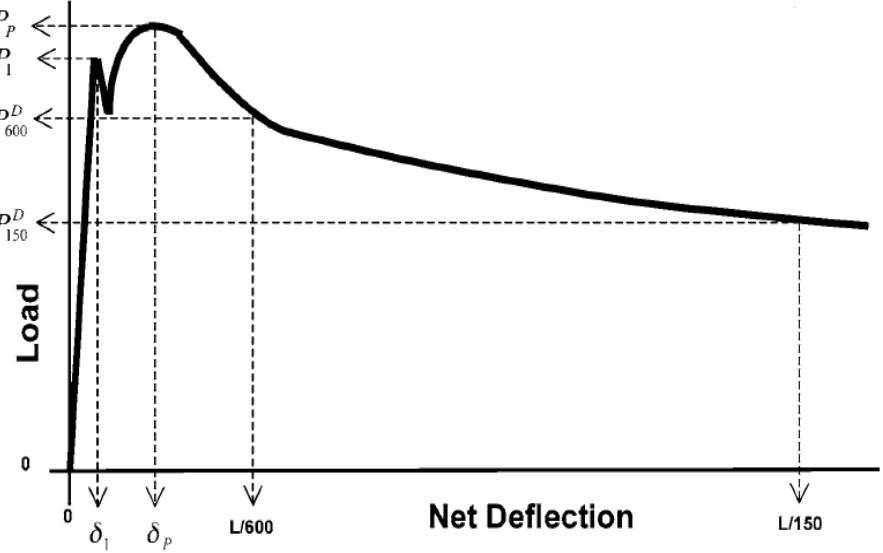
Figure 4. Schematic diagram of the load-deflection curve for calculating first-peak strength, residual